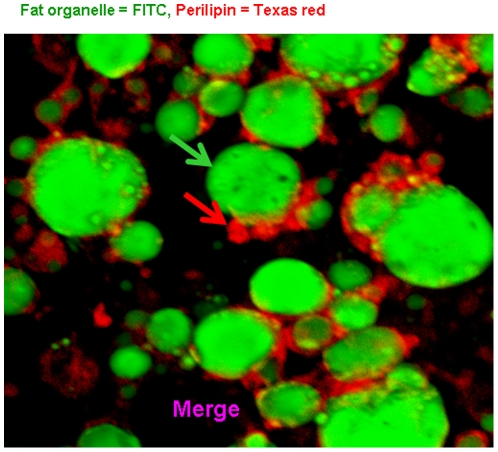
Confocal laser scan microscopy (CLSM) analysis of Perilipin in adipocytes.CLSM was used to validate and localize perilipin protein in human adipocytes as shown in figure 3. Fat organelles ( =  lipid droplets) were stained with FITC (green color), indicated by green arrow, and Perilipin was visualized with Texas red (red color) shown by red arrow. Perilipin was localized at the surface of fat organelles.